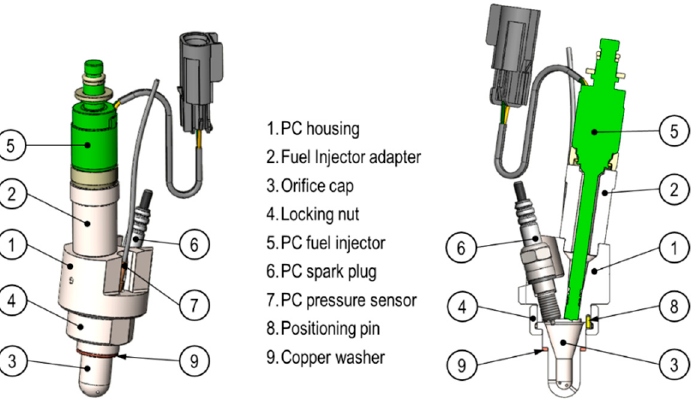
Figure 2. Components of the developed pre-chamber ignition system.